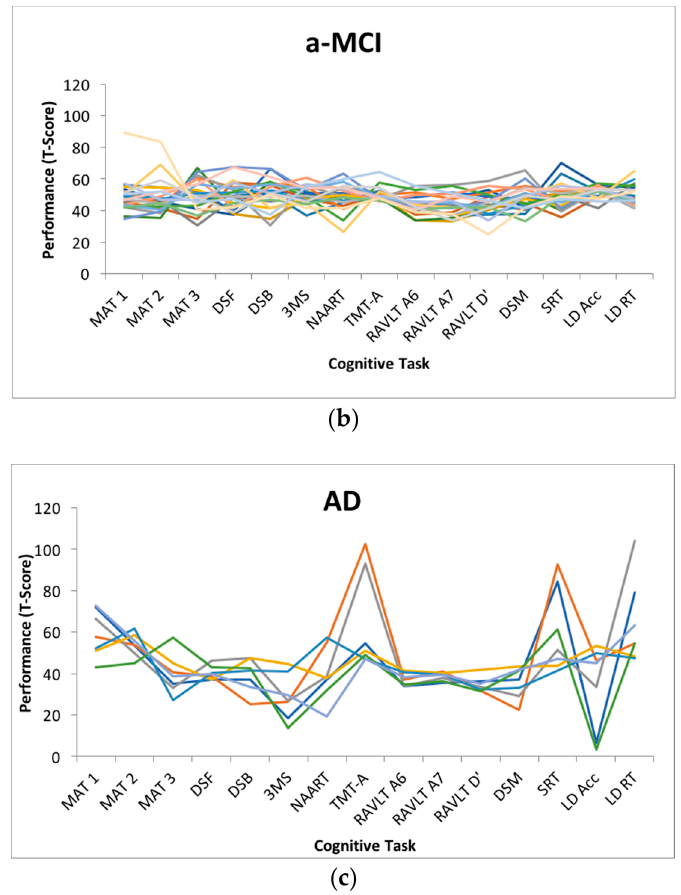
Figure 1. Dispersion profiles for each group of participants, classified as ( a ) healthy control (HC), amnestic ( b ) Mild Cognitive Impairment (a-MCI) and ( c ) Alzheimer’s disease (AD).